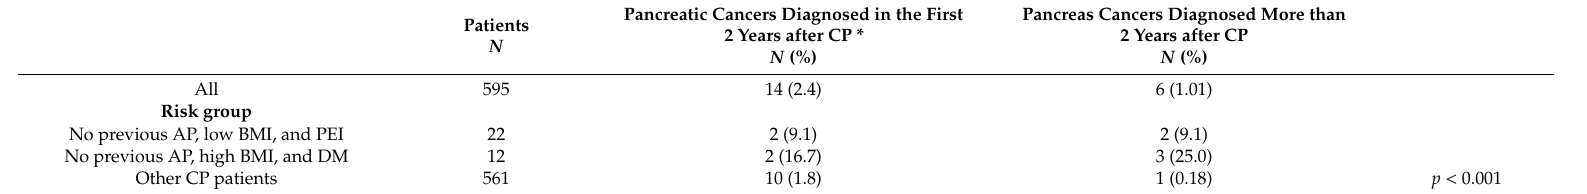
Table 3. Pancreas cancer in patients with specific characteristics at diagnosis of CP. Patients